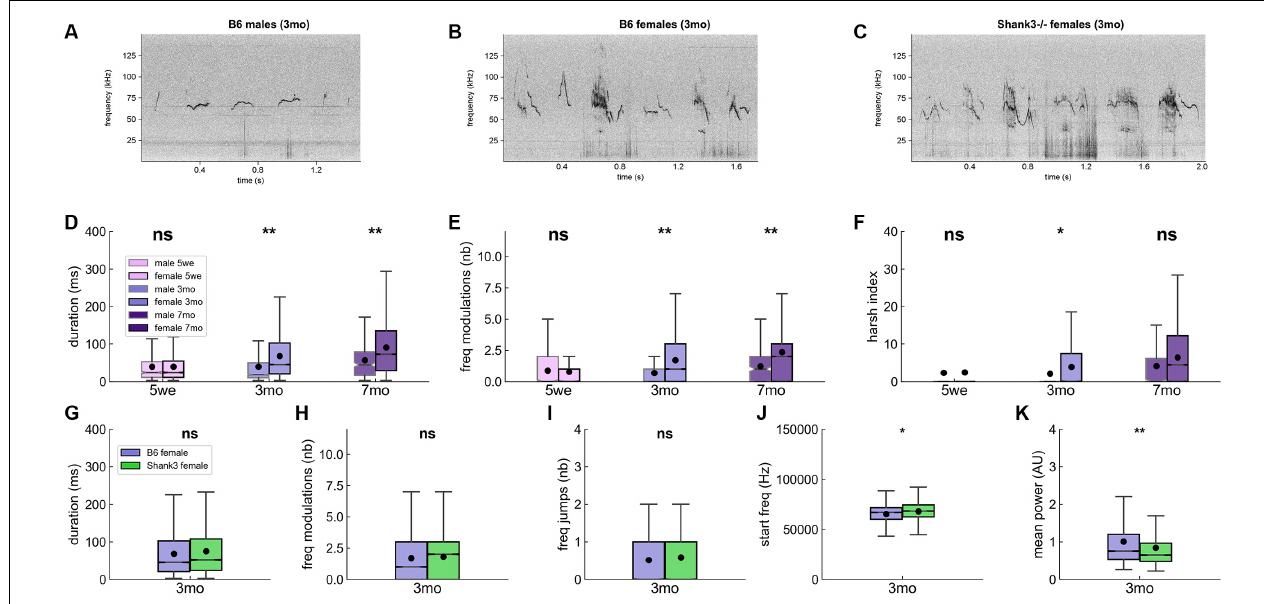
FIGURE 4 | Acoustic characteristics over age and sex classes in B6 male and female pairs of mice and in Shank3 − / − female pairs. Spectrograms of six examples of USVs in (A) B6 males, (B) B6 females, and (C) Shank3 − / − females aged 3 months (1,024 FFT points, 1.7 ms time resolution, Hamming window, 50% overlap). Comparisons of the duration of the USVs (D) , number of frequency modulations per USV (E) , and harsh index of the USVs (F) between males and females at 5 weeks (males: 630 USVs, females: 7,167 USVs), 3 months (males 688 USVs, females: 26,357 USVs) and 7 months (males: 241 USVs, females: 33,954 USVs) of age in B6 mice (Linear Mixed Model with sex as fixed factor and pair as random factor). Comparisons of the duration of USVs (G) , the number of frequency modulations per USV (H) , the number of frequency jumps (I) , the frequency at the beginning of the USV (J) , and the mean power of USVs (K) between B6 females (26,357 USVs, purple) and Shank3 − / − females (33,162 USVs, green) aged 3 months (Linear Mixed Model with genotype as fixed factor and pair as random factor). ns, not significant; uncorrected p -values: * p < 0.05, ** p < 0.01. None of the tests survived a correction for multiple